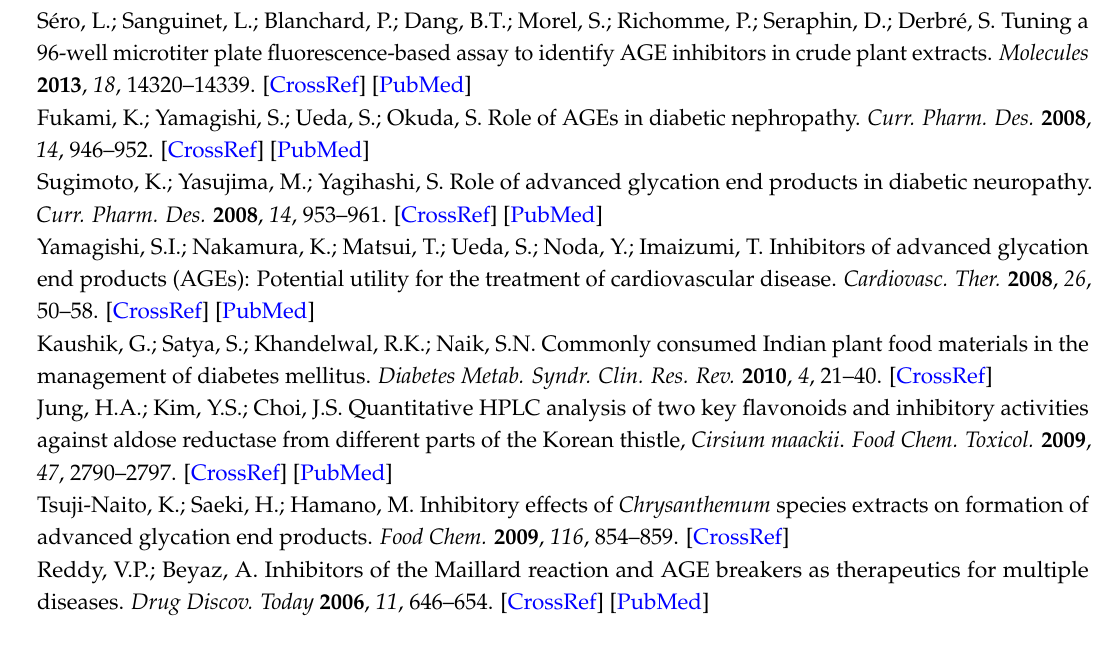
Table S1: MS fragmentation of the investigated compounds (verbascoside, baicalin, wogonoside)